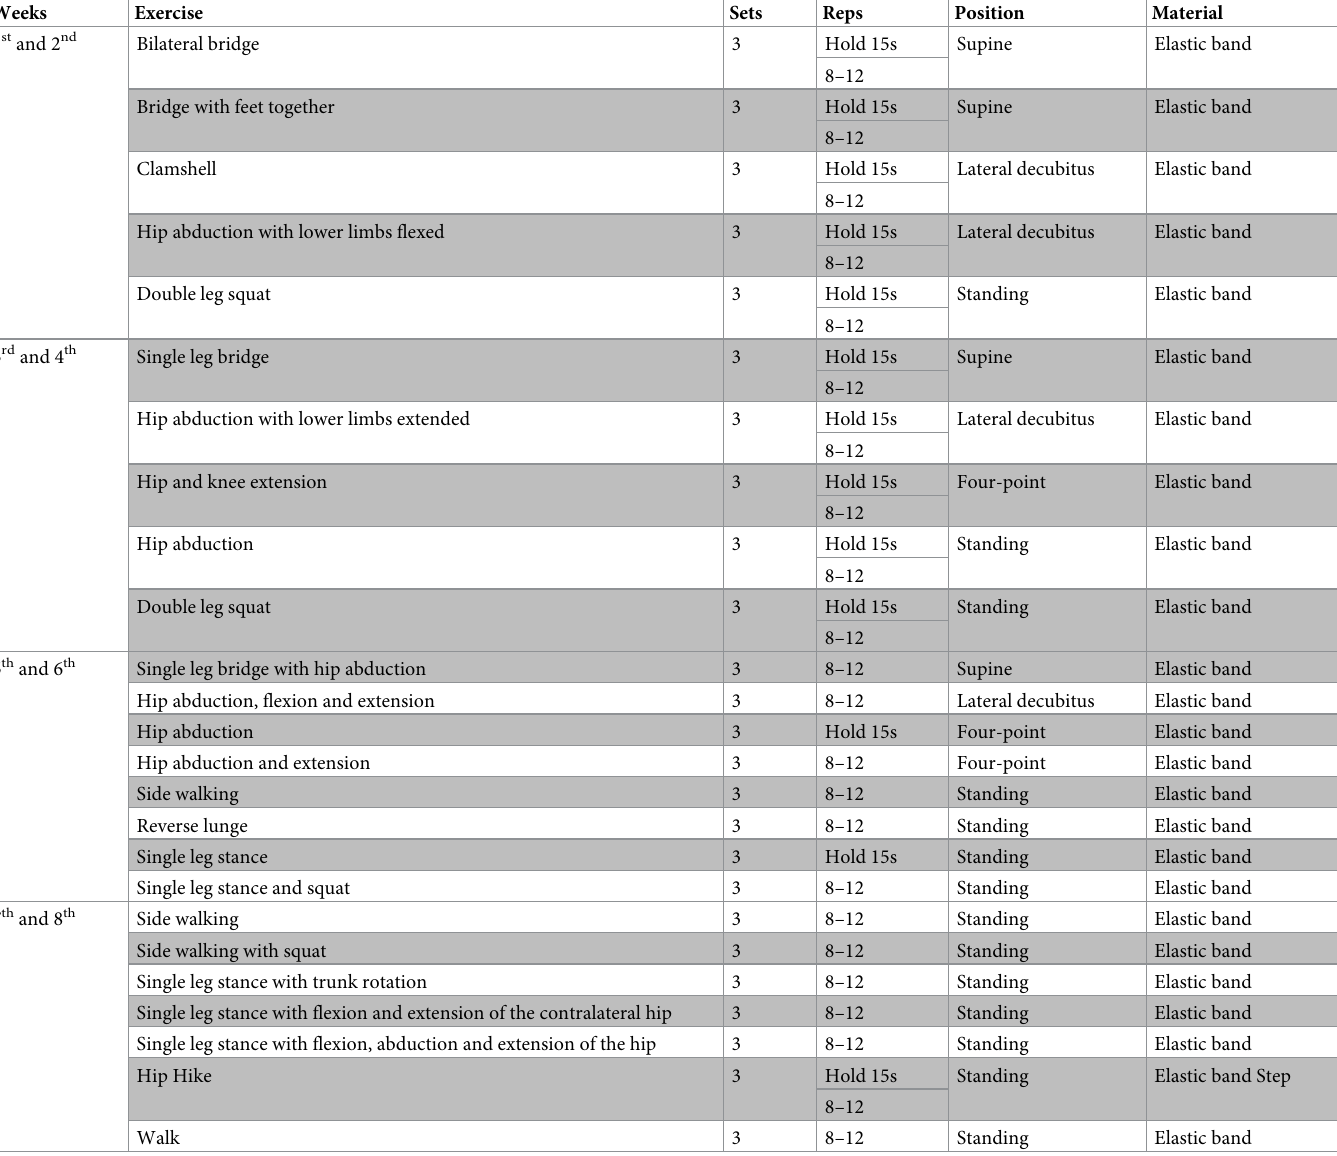
Table 1. Exercise dosage and progressions of motor control